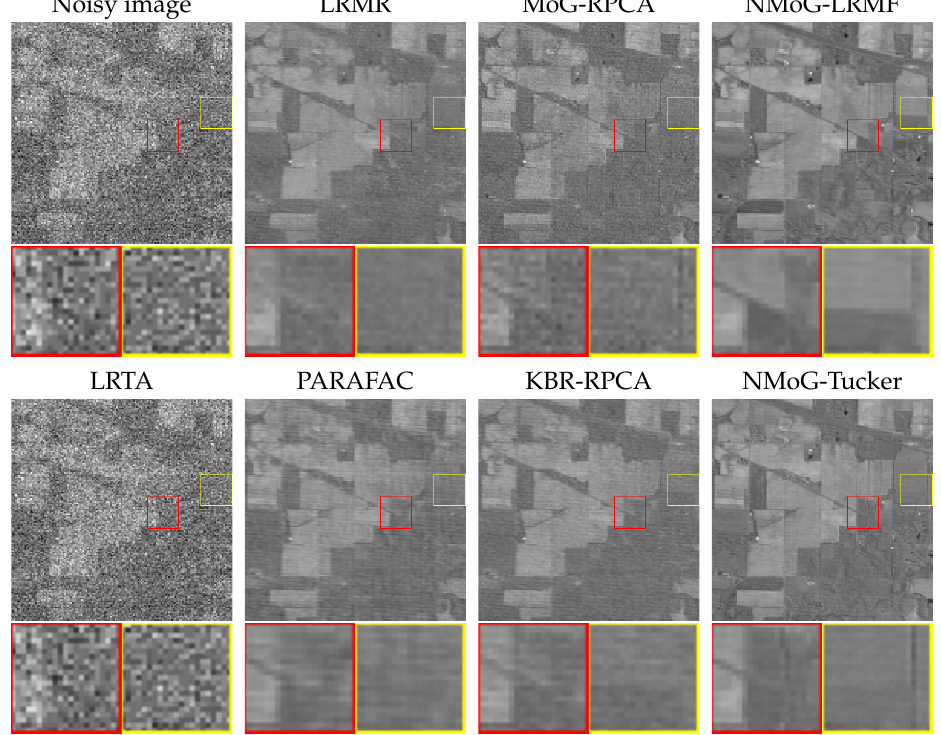
Figure 6. Real HSI denoising example on band 220 in Indian Pines . For better visualization, we show enlargements of two demarcated patches.